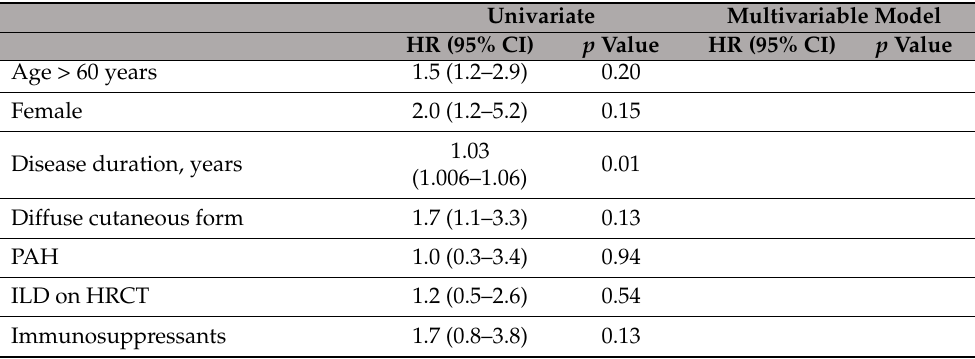
Table 5. Univariate and Multivariable Predictors of MACEs.